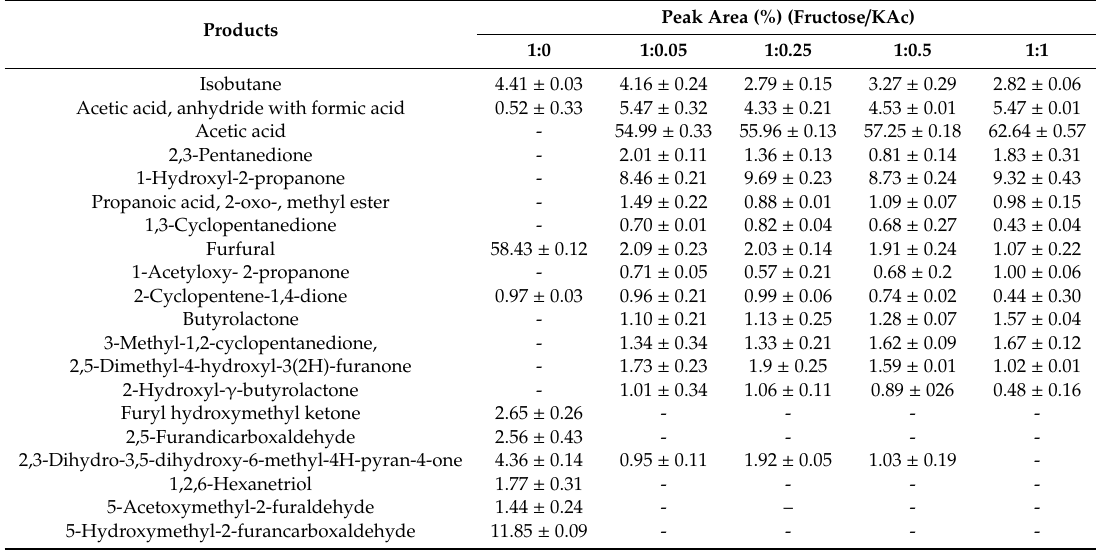
Table 7. Peak area (%) of the typical products derived from the fructose in situ catalytic pyrolysis at 350 ◦ C with the di ff erent fructose / KAc